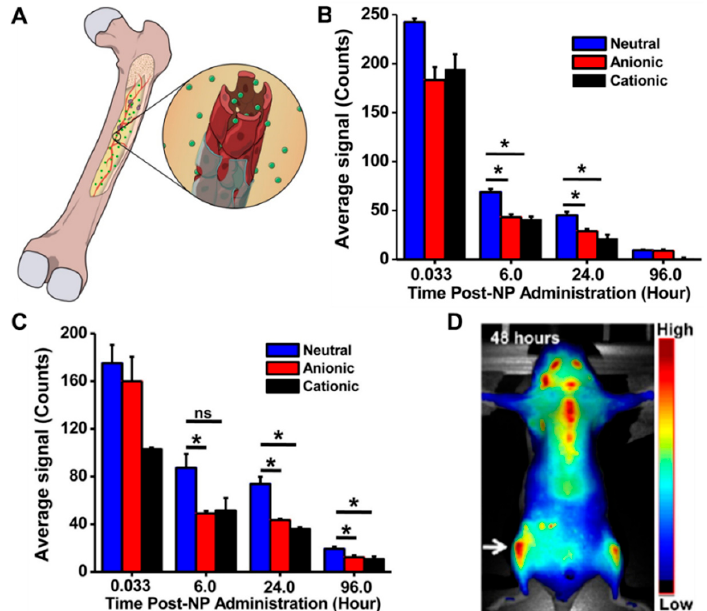
Figure 2. Passive targeting of nanoparticles to bone marrow. ( A ) Scheme showing passive targeting of NPs (green spheres) into bone. NPs pass through the fenestrations in sinusoidal capillaries to localize in bone marrow. NP ( B ) charge on blood residence time and ( C ) bone accumulation. Neutral charge NPs showed greater accumulation in tibia than similarly sized anionic and cationic NPs. ( D ) Neutral charge NPs showed greater localization in tibia with bone metastasis (white arrow) than healthy tibia. Reprinted with permission from Reference [93].